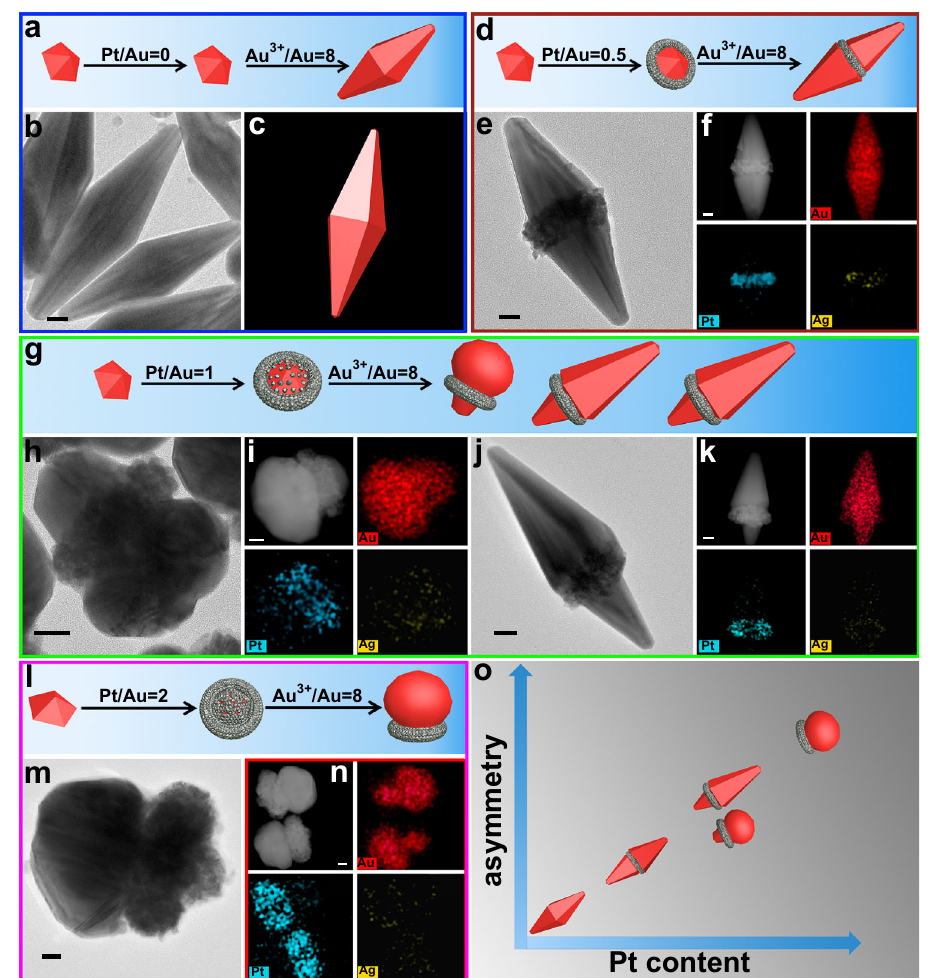
Fig. 3 Au growths on AuND-based nanocrystals. TEM images, STEM-HAADF images, STEM-EDS elemental maps, and schematic illustrations of products prepared through growing Au on AuND@PtNC nanocrystals with different molar ratios of Pt/Au: a , b , c 0; d , e , f 0.5; g , h , i , j , k 1; l , m , n 2. o Schematic evolution of spatial con fi guration with Pt. All scale bars are 20 nm. In all schematics, the red and gray colors represent Au and Pt,